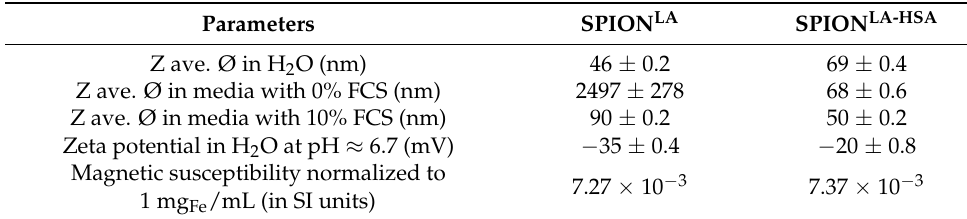
Table 1. Physicochemical characterization of superparamagnetic iron oxide nanoparticles. The hydrodynamic diameter of SPION LA and SPION LA-HSA were determined in H 2 O, media with 0% FCS and media with 10% FCS. Zeta potential and magnetic susceptibility were measured in